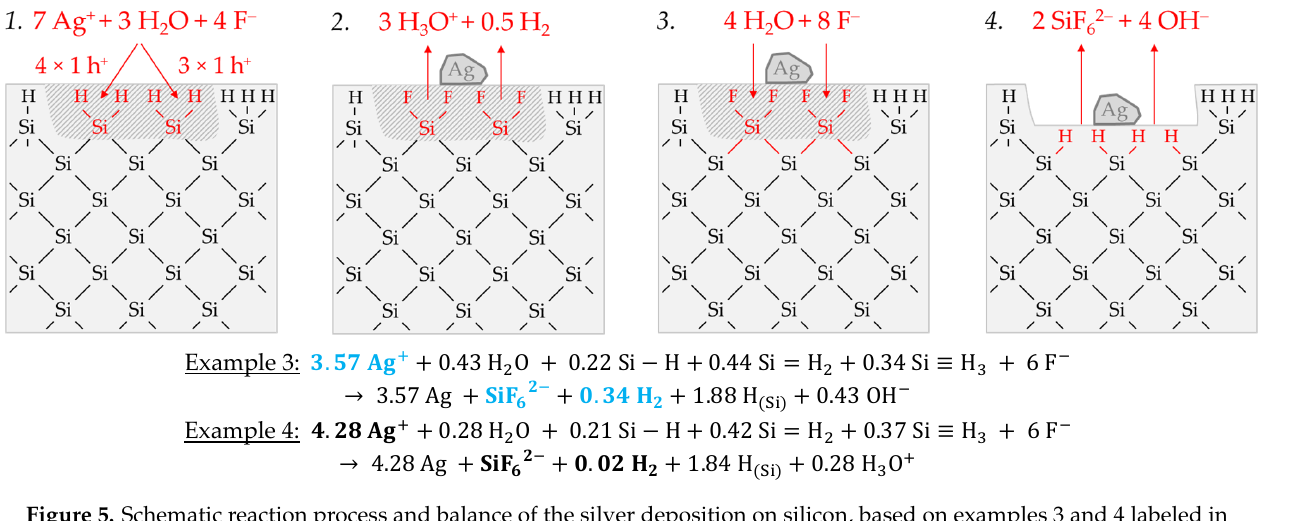
Figure 5. Schematic reaction process and balance of the silver deposition on silicon, based on examples 3 and 4 labeled in Figure 2e,f, with a ∆ n Ag : ∆ n Si: ∆ n H 2 ratio of ≈ 3.57:1:0.34 and 4.28:1:0.02 mol:mol:mol,